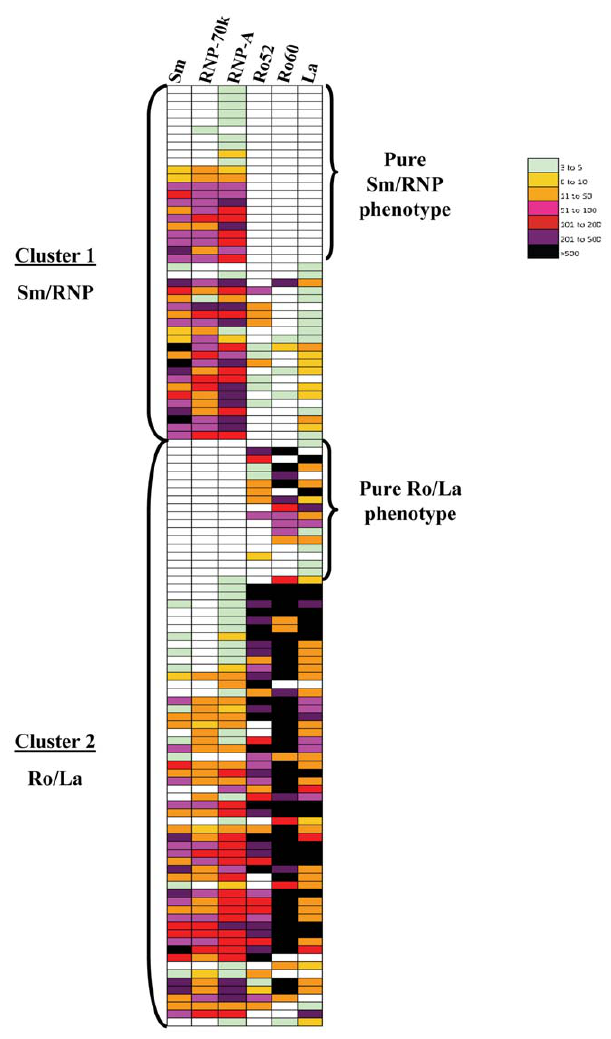
Figure 2. Validation of two major autoantibody clusters in SLE. A second SLE cohort was analyzed for autoantibody titers. A heatmap